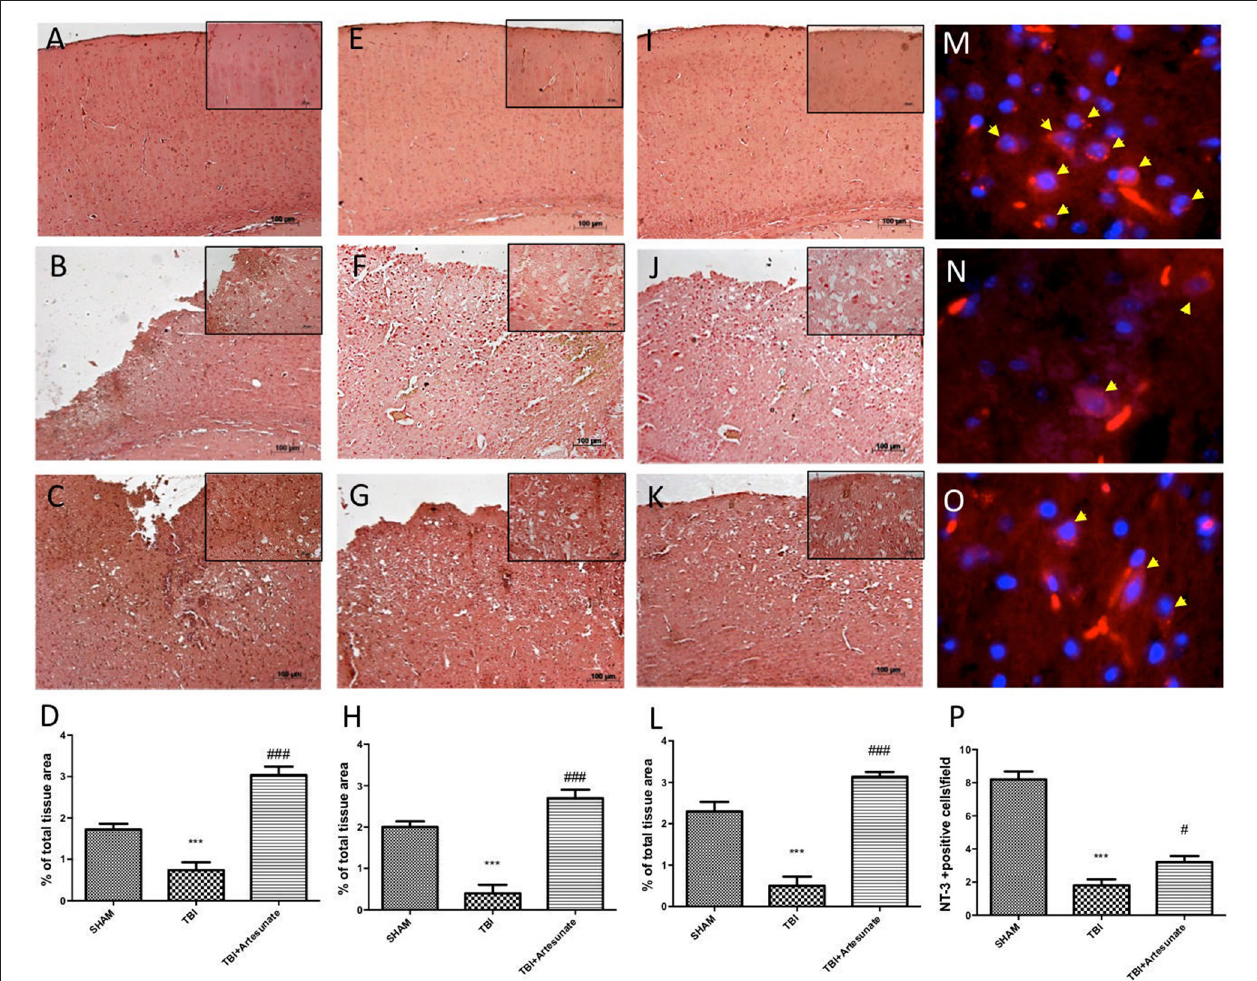
FIGURE 8 | Protective effect of artesunate treatment on neutrophic factors. (A) Show the immunohistochemical expression of VEGF in brain section from sham group, (B) show a significant reduction in VEGF expression 24h after TBI injury in brain section from vehicle group, instead (C) show that treatment with artesunate significantly increase the VEGF expression compared with the vehicle group, (D) VEGF density. (E,I) Show basal expression for BDNF and GDNF respectively in brain section from sham mice. 24h after TBI there is a significantly reduction in BDNF and GDNF expression as show in (F,J) respectively, instead (G,K) show that treatment with artesunate is able to significantly increase the expression of BDNF and GDNF respectively (H,L) BDNF and GDNF density. (M) Show the basal NT-3 immunoreactivity (red signal) in brain from sham mice. (N) Brain tissue from TBI group showed a significant reduction in NT-3 levels. (O) When compared with TBI group the brain section from mice that have been treated with artesunate showed a significant increase in NT-3 levels. (P) , NT-3 density. Data are expressed as Mean ± SEM from N = 10 Mice for each group, *** P < 0.001 vs. corresponding sham group. # P < 0.05 vs. corresponding TBI. ### P < 0.001 vs. corresponding TBI. ( F -value for VEGF = 41.8. df = 2. r 2 = 0.8745) ( F -value for BDNF = 38.97m. df = 2. r 2 = 0.8666) ( F -value for GDNF = 46.41. df = 2. r 2 = 0.8855) ( F -value for NT-3 = 65.31. df = 2. r 2 =